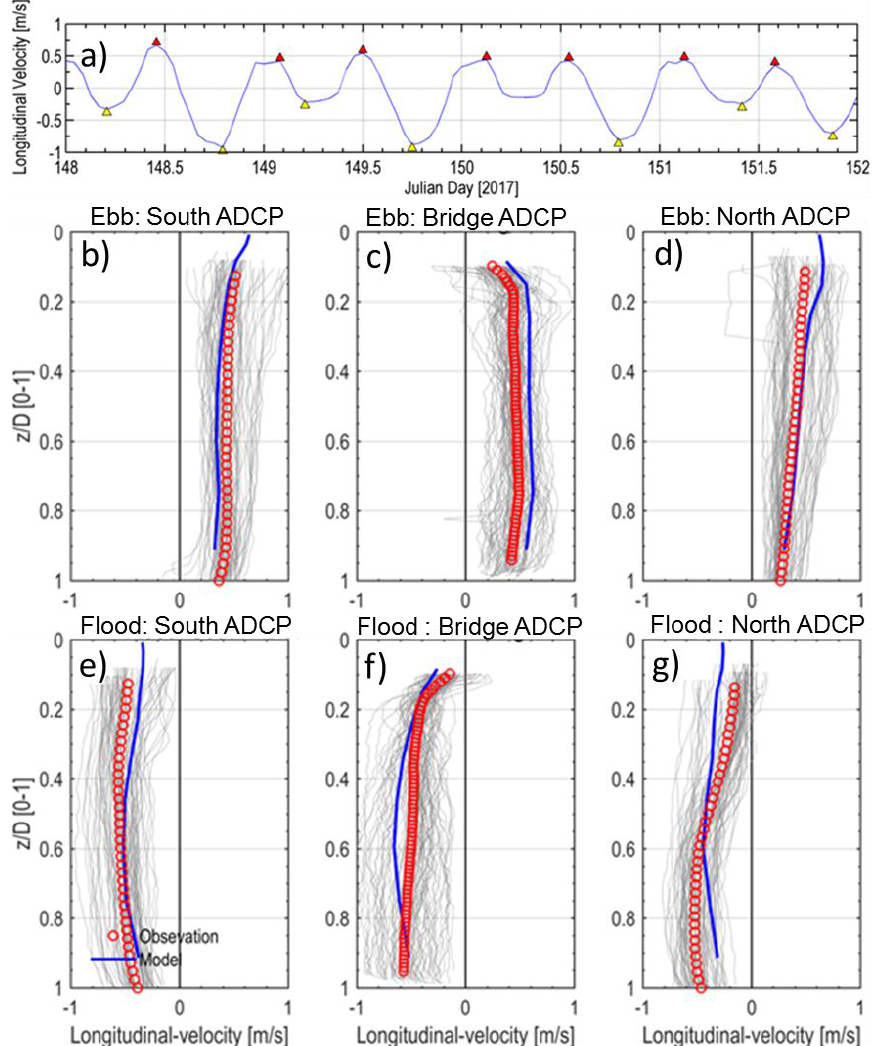
Figure 12. ( a ) Time series of depth-averaged velocity at bridge; ( b – g ) comparisons of predicted and observed average velocity profiles at the South, Bridge, and North ADCP stations during maximum flood and ebb tide periods. Gray thin lines represent daily velocity profiles during peak ebb and flood periods.